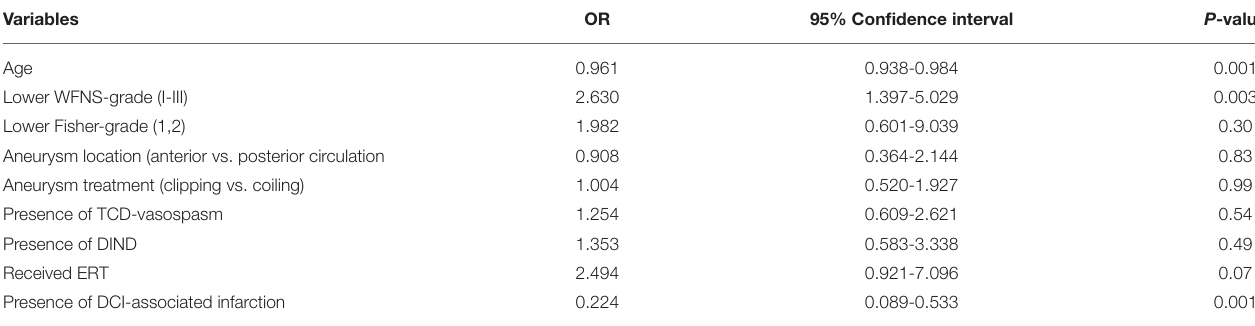
TABLE 2 | Multivariate logistic regression analysis for identification of predictors of good clinical outcome (mRS ≤ 2).